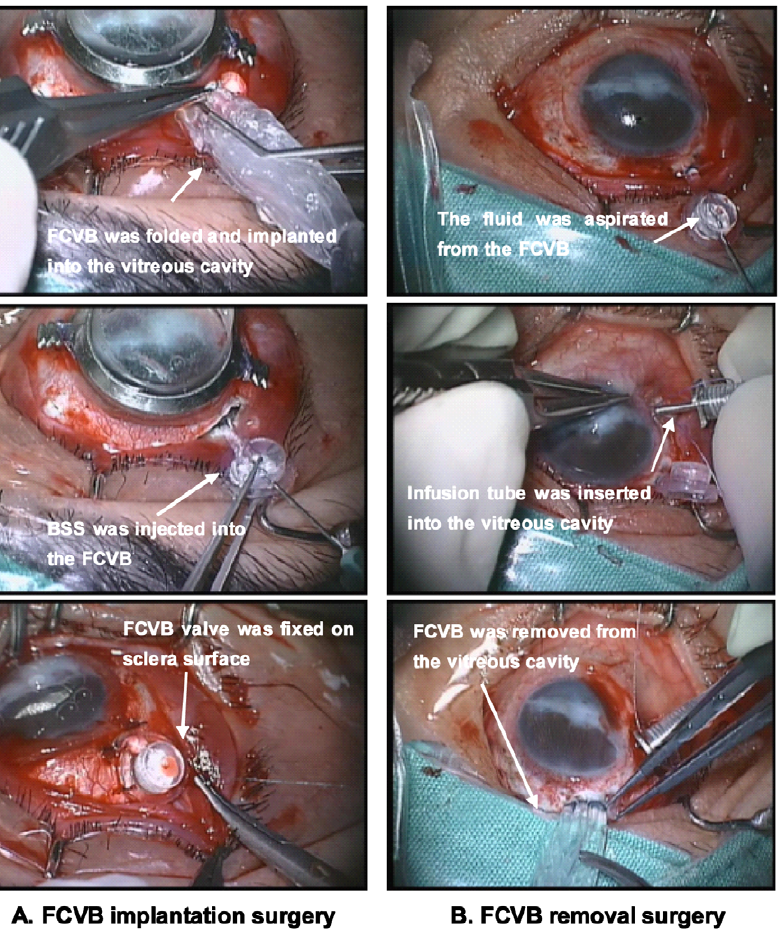
Figure 1. The implantation and removal surgery of FCVB on the same eye of Patient 04. A. FCVB implantation surgery: The FCVB was triple-folded and implanted into the vitreous cavity. Approximately 4.0 ml of BSS was injected into the capsule to support the retina. The valve and tube were subsequently fixed on the scleral surface. B. FCVB removal surgery: The fluid inside the FCVB was aspirated by a 2 ml-syringe, prior to intraocular infusion of BSS. The capsule was cut as needed to allow FCVB removal.